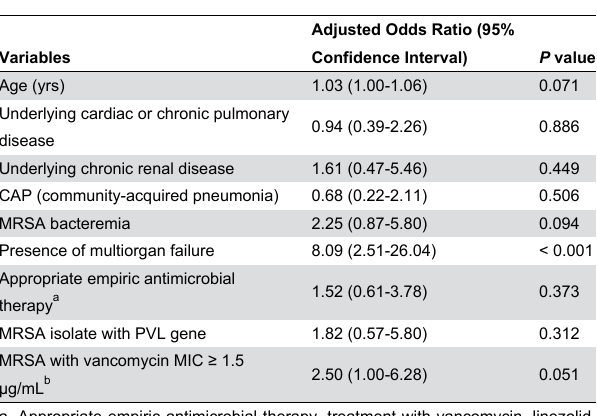
Table 4. Multivariate analysis of variables associated with 30-day all-cause mortality in patient with methicillin- resistant Staphylococcus aureus (MRSA)